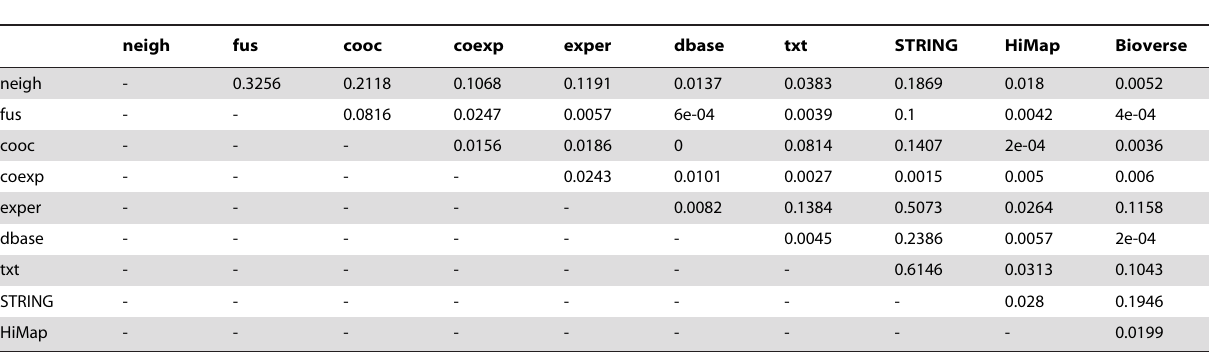
Table 2. Correlation of scores from different